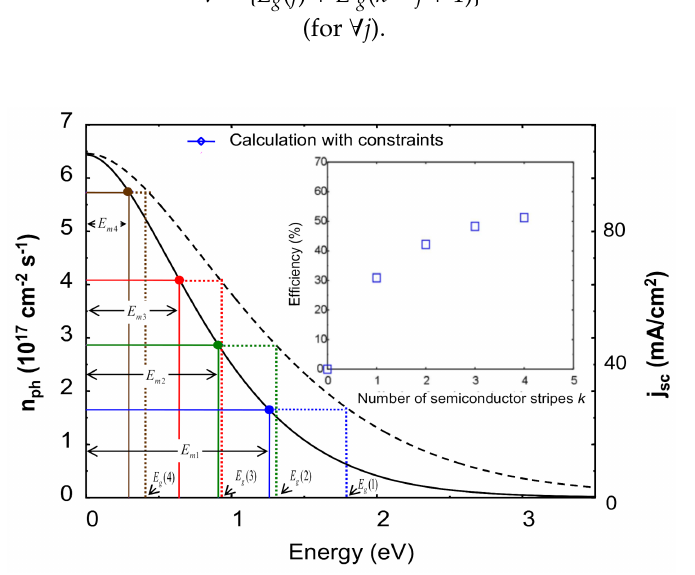
Figure 15. Optimum energy-gap selection for connected MOP 3 SC (for k = 4) (Reproduced from [38], the union of ecodesigners,